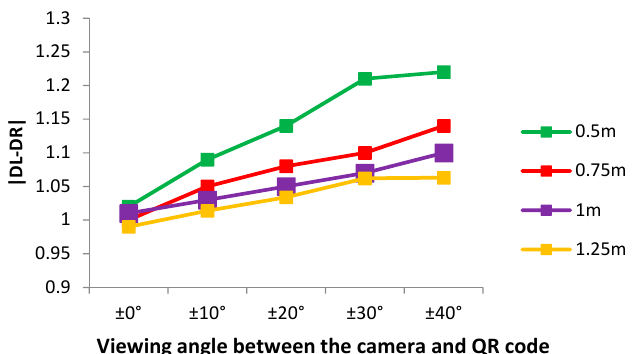
Figure 9. Relationship between the viewing angles and the |DL-DR| values.